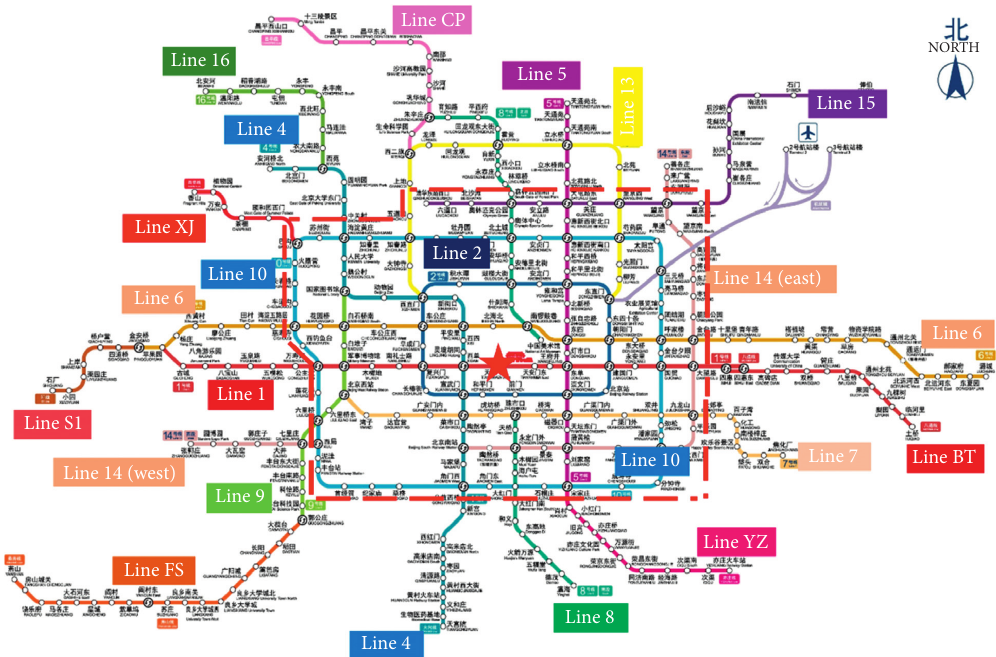
Figure 6: Beijing metro